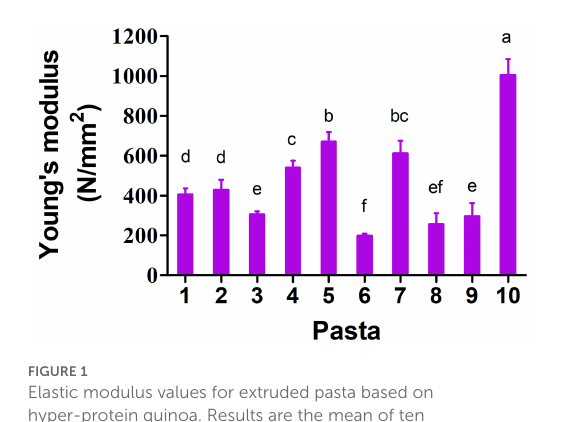
FIGURE1 Elastic modulus values for extruded pasta based on hyper-protein quinoa. Results are the mean of ten determinations ( n = 10), ± represents the standard deviation. Similar lower-case letters show no statistical difference between treatments ( p <